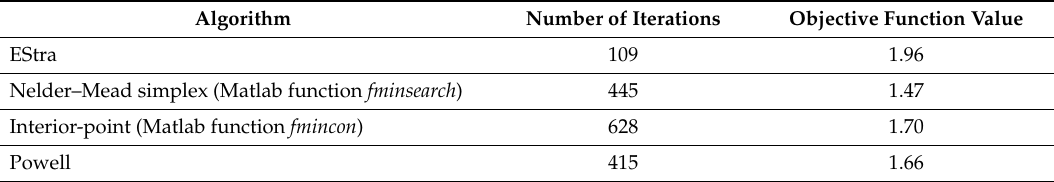
Table 2. Comparison of convergence and objective function value for several optimization algorithms.